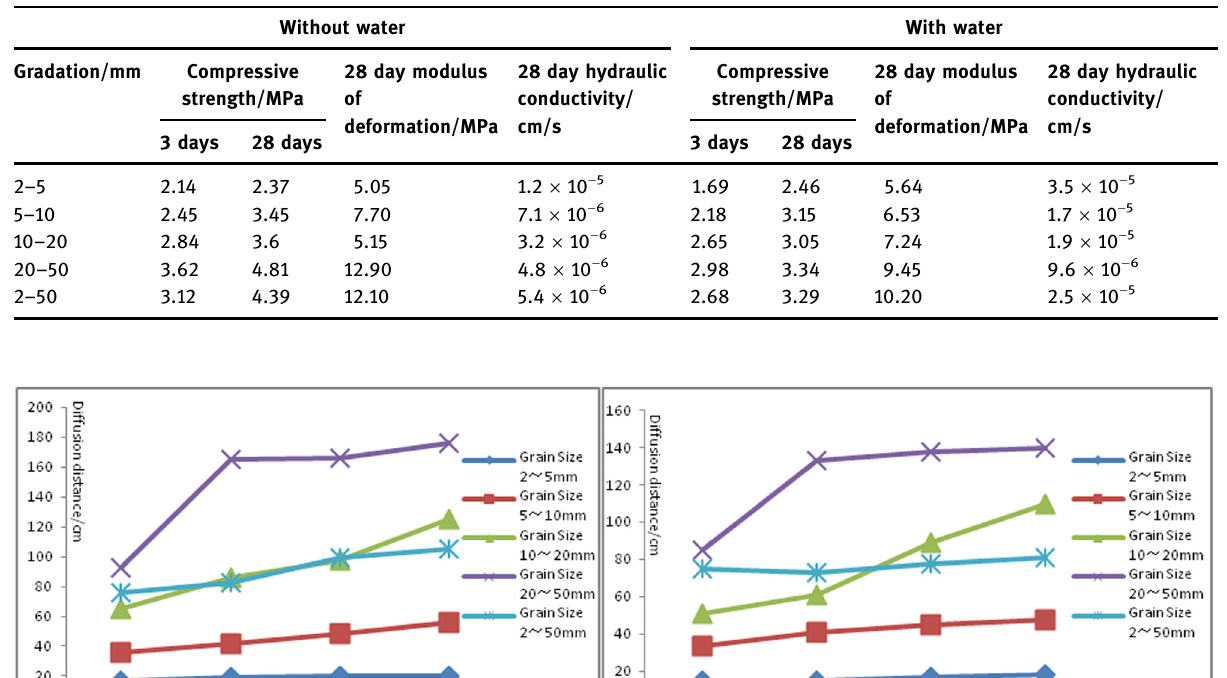
Table 4: Mechanical performance of asphalt concretions in the 1D experiment model